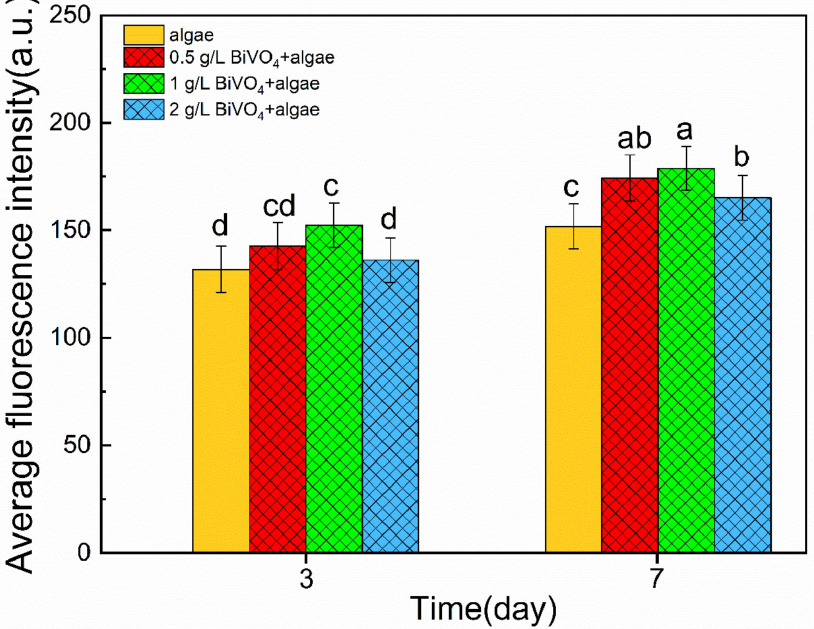
Figure 2. Effect of the treatment group (BiVO 4 –algae) and control group (algae) on average autofluo- rescence intensity of Dictyosphaerium sp. on days 3 and 7 of the experiment. Identical letters denote no significant difference ( p <